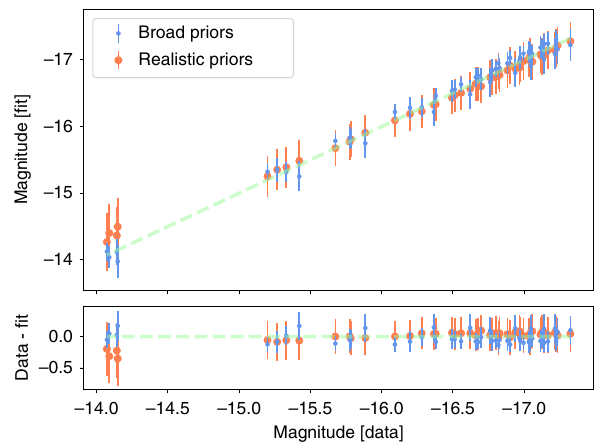
Fig. 9 Fundamental plane plot. The top panel shows the fi t of Eq. (3) for the models in Bulla 25 model. The Broad Priors values are derived from the entire available grid, covering a range (cid:2) 6 (cid:3) log 10 ð M ej = M (cid:4) Þ (cid:3) (cid:2) 0, 15° ≤ Φ ≤ 75°, and 0° ≤ θ ≤ 90°. The Realistic Priors values are derived from a obs fraction of the grid drawn from the sGRB informed priors, covering a range (cid:2) 3 (cid:3) log ð M = M Þ (cid:3) (cid:2) 1, 15° ≤ Φ ≤ 30°, and 0° ≤ θ ≤ 15°. The bottom (cid:4) obs 10 ej panel shows the difference between the computed values from the model and the fi ts for the simulations analyzed here. The 1 − σ error bars correspond to those assigned by the Gaussian Process